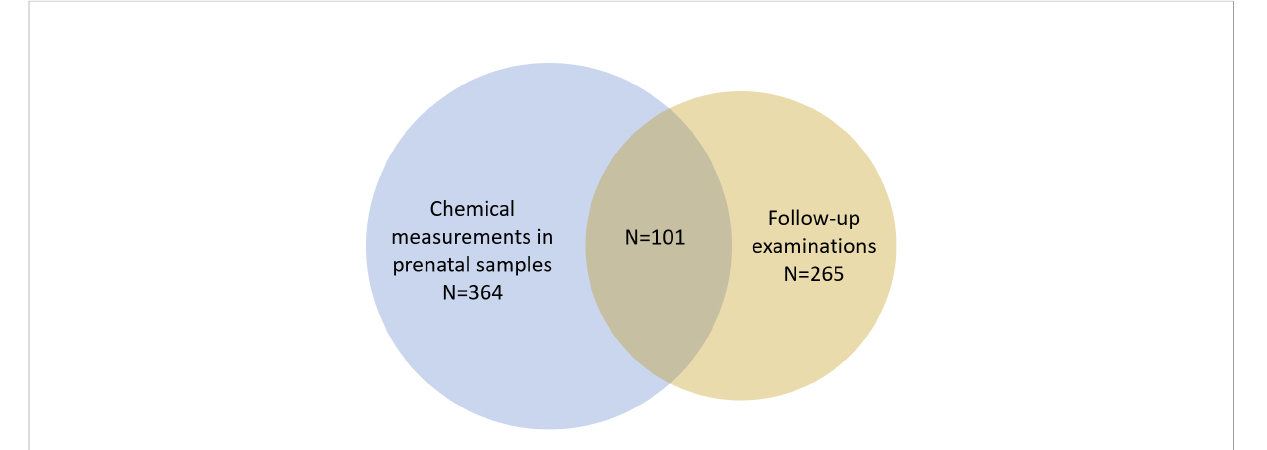
FIGURE 1 Overview of number of chemical measurements in prenatal samples and number of sons with a follow-up